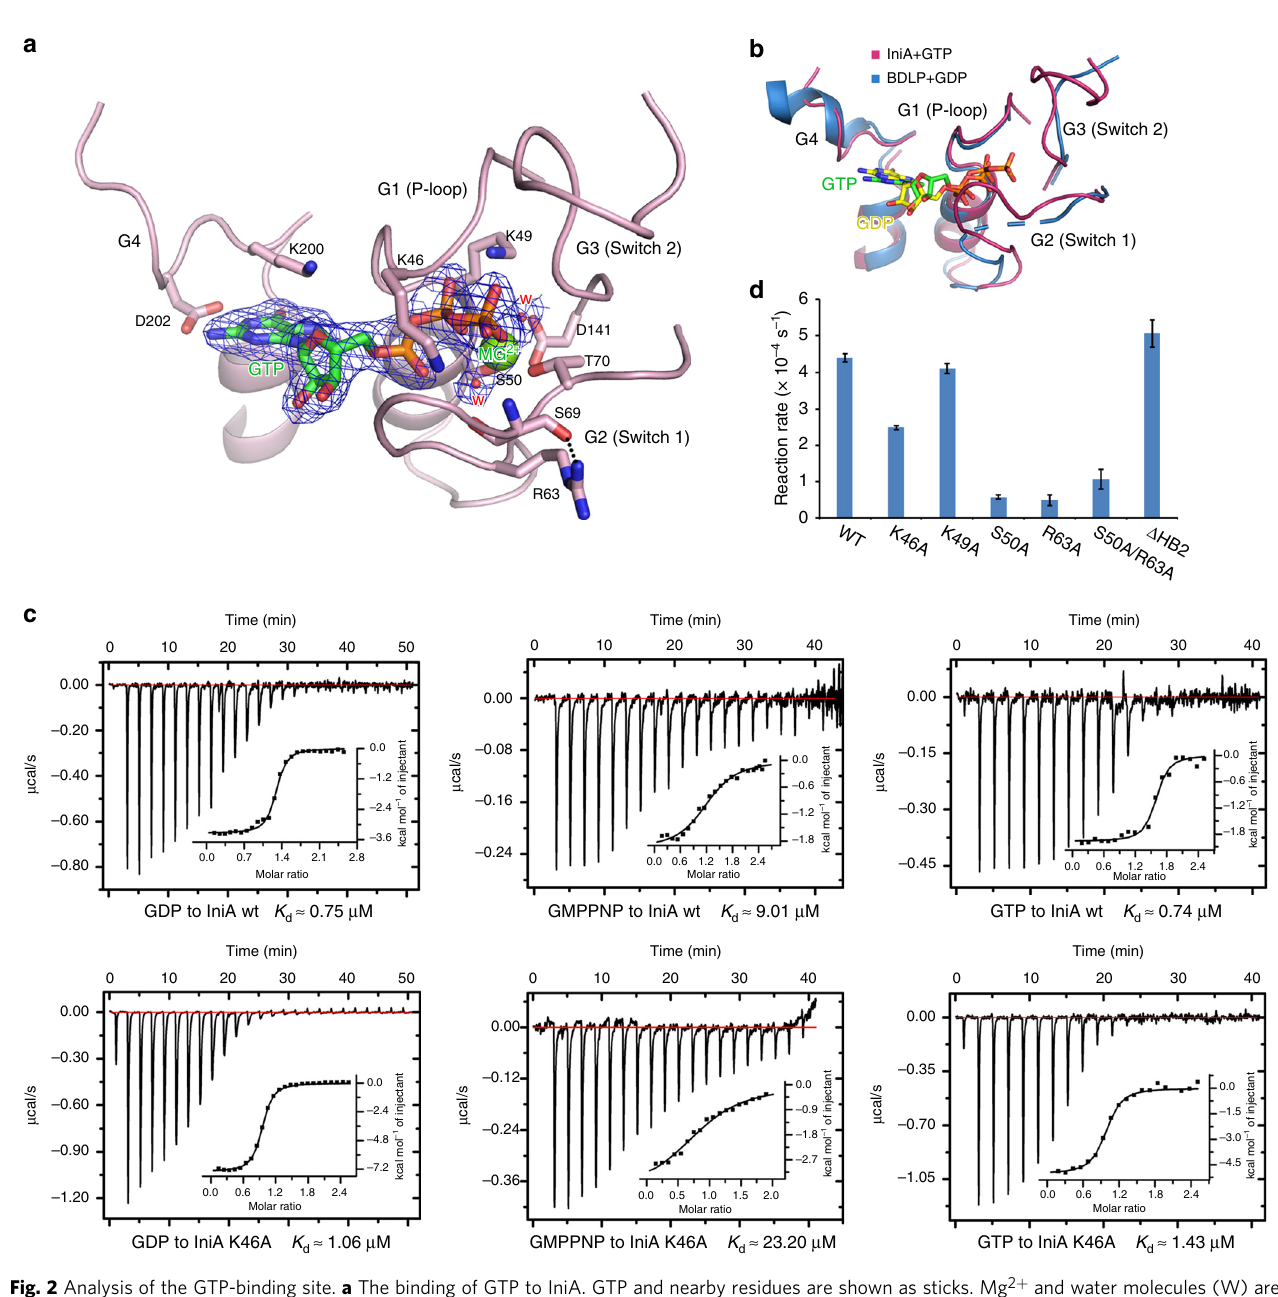
Fig. 2 Analysis of the GTP-binding site. a The binding of GTP to IniA. GTP and nearby residues are shown as sticks. Mg 2 + and water molecules (W) are represented by spheres. The 2 F o – F c electron density maps (contoured at 1.0 σ ) of GTP, Mg 2 + , and water molecules are shown as wire mesh (blue). The hydrogen bond between S69 and R63 is indicated by the dashed line. b Structural alignment of nucleotides and conserved motifs between IniA and cyanobacteria BDLP. The dashed loop represents un-modeled fragment in BDLP. c Binding af fi nity of GDP/GMPPNP/GTP for wild-type (wt) IniA and the K46A mutant measured by ITC. The dissociation constant, K d , is given below. The data are representative of at least three repetitions. d GTPase activity of IniA and different mutants. The activities were measured by the reaction rate at 0.5 mM GTP. Each bar is the mean and SD of three measurements. The source data of Fig. 2d are provided in the Source Data fi